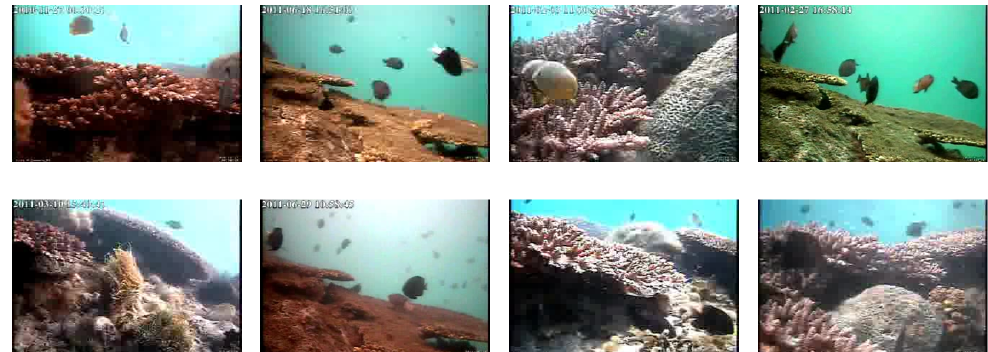
Figure 1. Examples of underwater images from different videos of the LifeClef 2015 Fish dataset. These examples illustrate the high variation in unconstrained underwater environments such as complex, crowded and dynamic backgrounds and luminosity